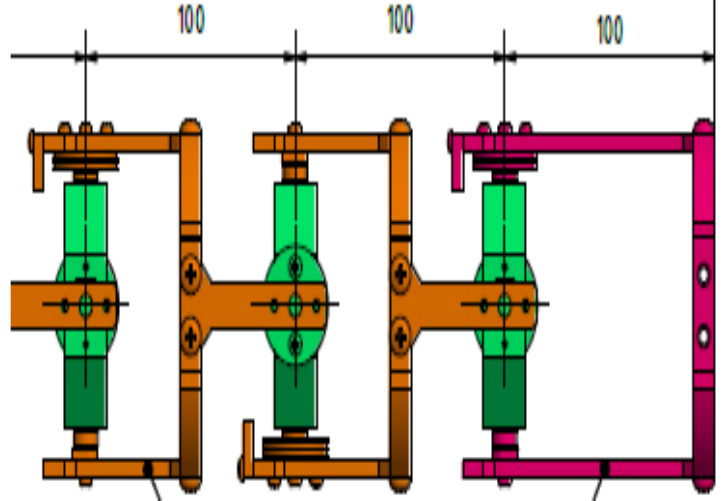
Figure 12. The last three joints’ structure.